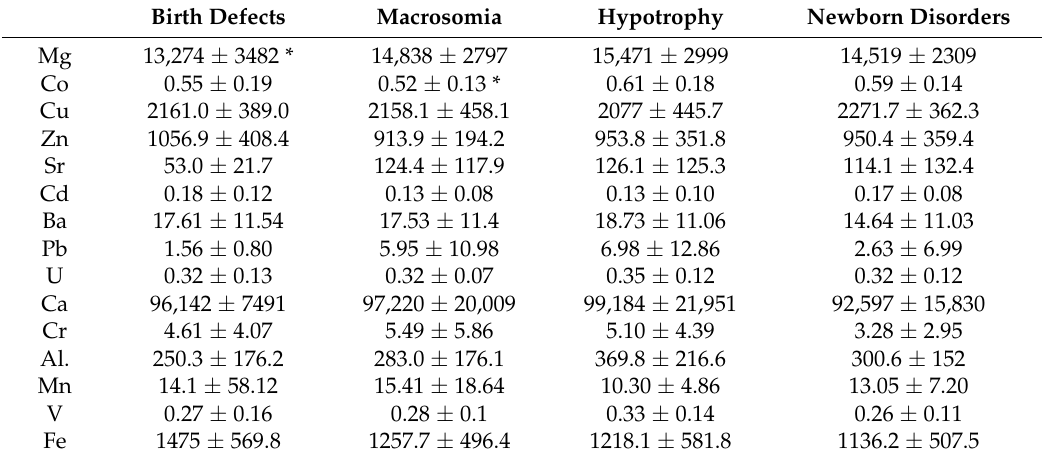
Table 2. Trace elements in maternal serum; mean ± SD/median/min-max ( µ g L − 1 ). Birth Defects Macrosomia Hypotrophy Newborn Disorders